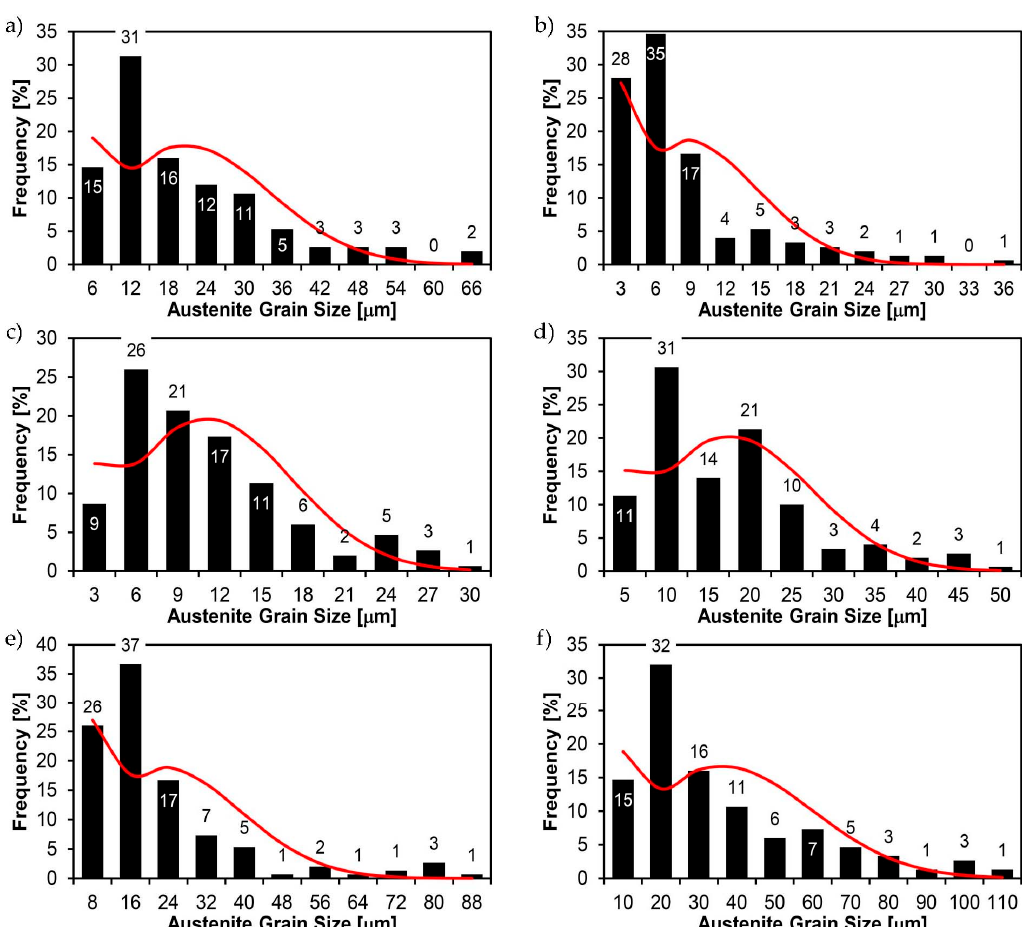
Figure 49. Frequency intervals and normal occurrence distributions of the determined grain sizes of prior austenite in the welded joint zone of Hardox 450 steel marked as WM3 in Figure 2: ( a ) normalised state; ( b ) delivery state (directly after welding); ( c ) after austenitising at 900 ◦ C for 60 min; ( d ) after austenitising at 1000 ◦ C for 60 min; ( e ) after austenitising at 1100 ◦ C for 120 min; ( f ) after austenitising at 1200 ◦ C for 120